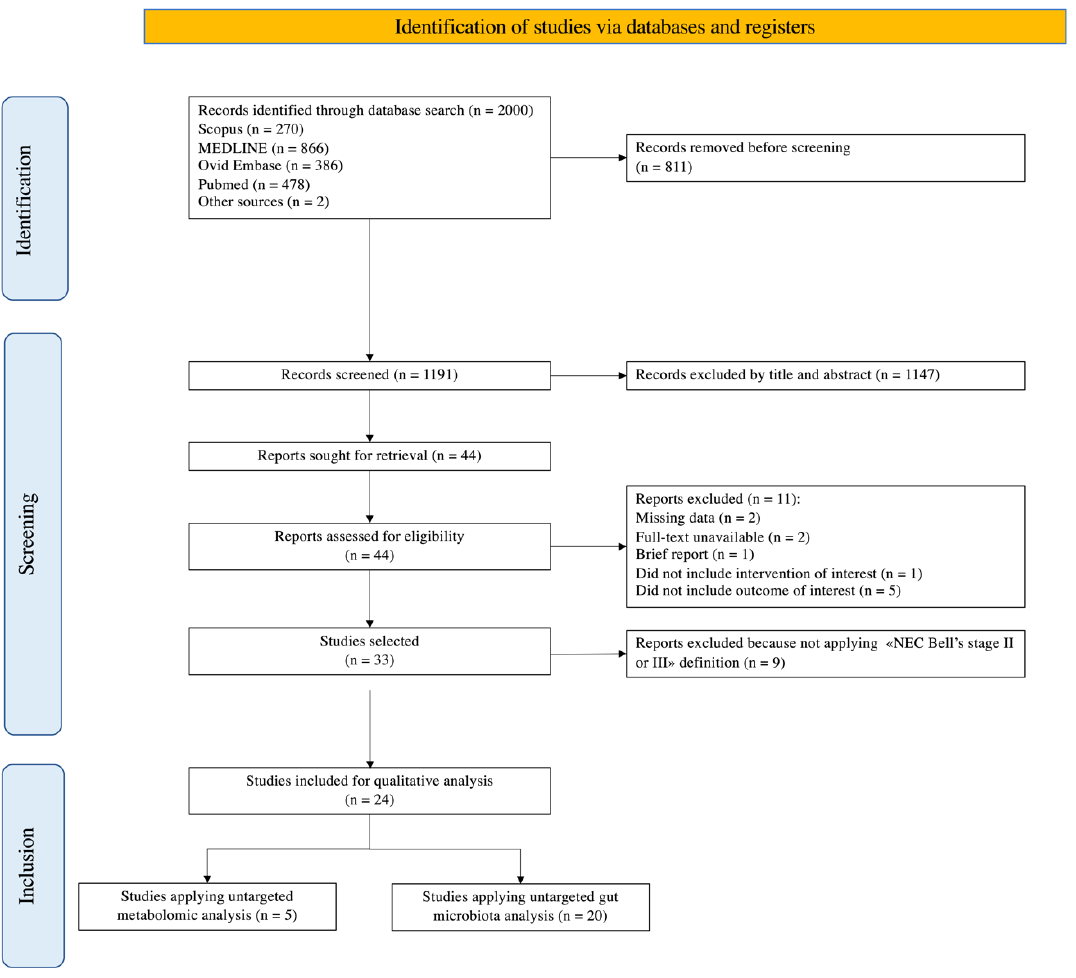
Figure 1. PRISMA flow diagram of the study.